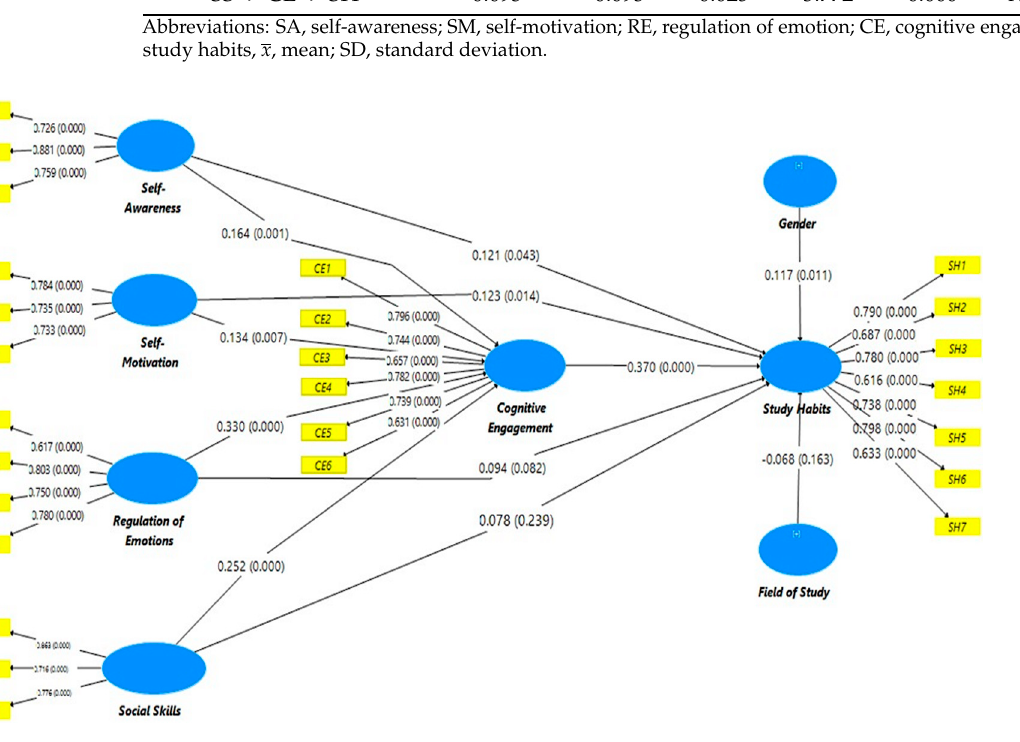
Figure 3. A path analysis model of emotional intelligence and study habits through cognitive en-